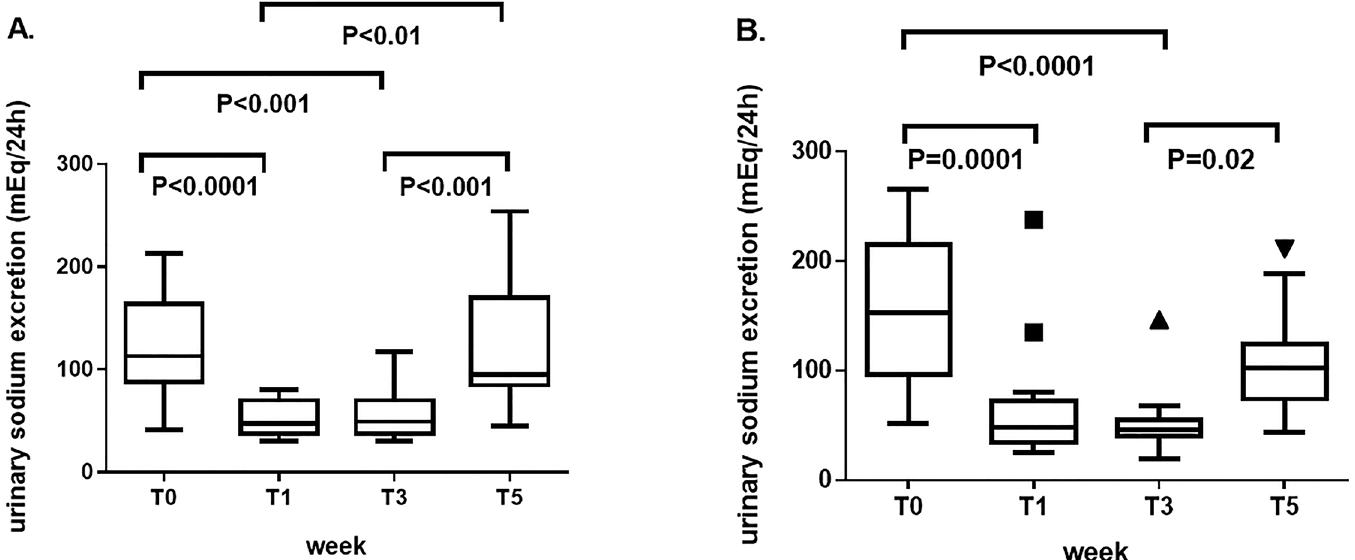
Fig 2. Comparison of urinary sodium excretion (mEq/24h) between the main timepoints of the study set at T0 (baseline, before starting the low- sodium dietary regimen), T1 (after 1 week, at the end of the “run-in” period of low-sodium dietary regimen), T3 (after 3 weeks, at the end of low- sodium dietary regimen), and T5 (at the end of the study, after 2 weeks of normal sodium dietary regimen). (A) In patients with rheumatoidarthritis, levels of 24-hoururinary sodium excretion significantly decreasedfrom T0 to T1 and from T0 to T3 (after 3 weeks, at the end of low-sodium dietary regimen), and increasedfrom T1 to T5 (at the end of the study, after 2 weeks of normalsodium dietary regimen)and from T3 to T5. (B) In patients with systemic lupus erythematosus, levels of 24-hoururinary sodium excretion significantly decreasedfrom T0 to T1 and from T0 to T3, and increasedfrom T3 to T5. Data are shown as Tukey boxplots;lines represent the medianlevel with 25 th -75 th percentile; data not includedbetweenthe whiskersare plotted as outliers with dots.